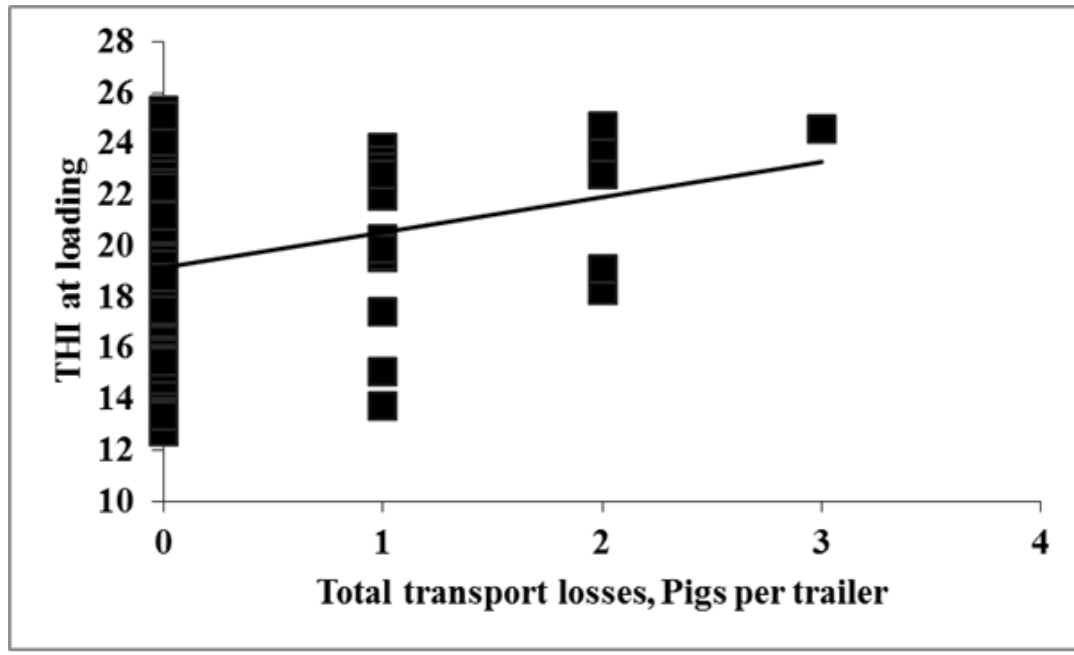
Figure 5. Experiment 2. Effects of THI at loading on total transport losses ( p = 0.01; R 2 =